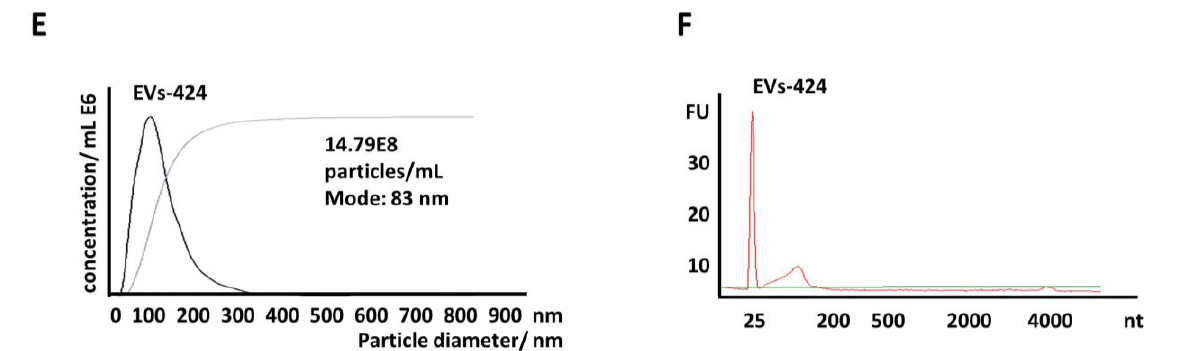
Figure 3. Isolation and characterization of extracellular vesicles (EVs) derived from adipose tissue-mesenchymal stromal cells (AT-MSCs). ( A ) EVs were isolated from the conditioned medium of AT-MSCs following the multicentrifugation method. ( B ) A phase-contrast transmission electron micrograph of the isolated exosomes. Scale bar: 100 nm. ( C ) Protein from AT-MSC cell lysates and EVs was analyzed by Western blotting with antibodies against CD9, CD63, CD81, CD105 and GAPDH. ( D ) Yields of EVs derived from AT-MSCs. Protein amounts and particle numbers of harvested EVs were determined by the Bradford method and nanoparticle tracking analysis (NTA), respectively. ( E ) Particle size distributions of EVs-424 were measured by NTA and showed a peak at 83 nm. ( F ) Bioanalyzer electropherogram of RNA extracted from EVs-424. The x -axis indicates the length of the RNA in nucleotides (nt), and the y -axis indicates the fluorescence intensity in arbitrary units. The lowest peak at 25 nt indicates the lower size marker. FU, fluorescent units.